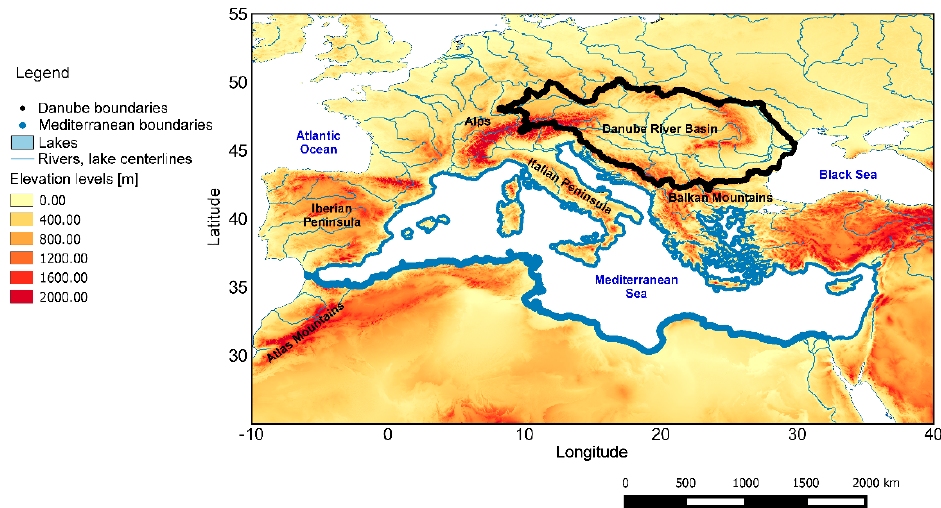
Figure 1. Map of Danube River Basin (black line) and Mediterranean Sea (blue line) as provided by the HydroSHEDS project (hydrological data and maps on shuttle elevation derivatives at multiple scale available online at https://hydrosheds.cr.usygs.gov).